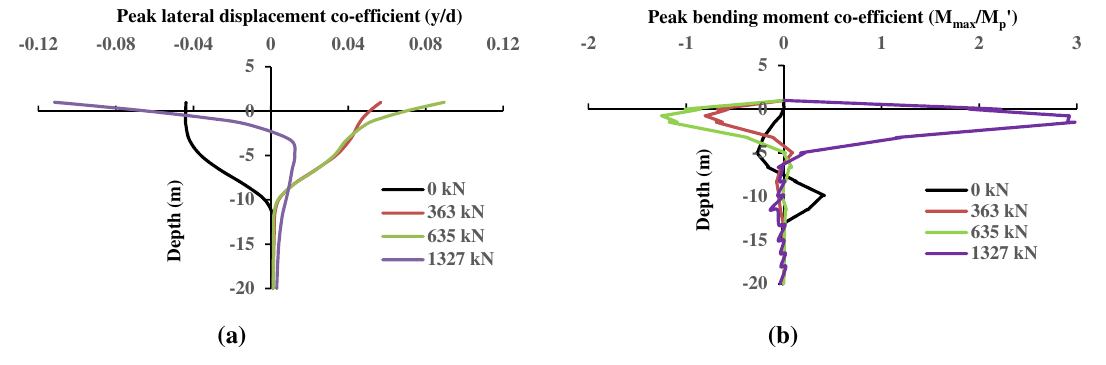
Fig. 15 Variation of a peak lateral displacement and b peak bending moment of pile for different combinations of vertical loading in RCD soil when subjected to scaled IMV motion